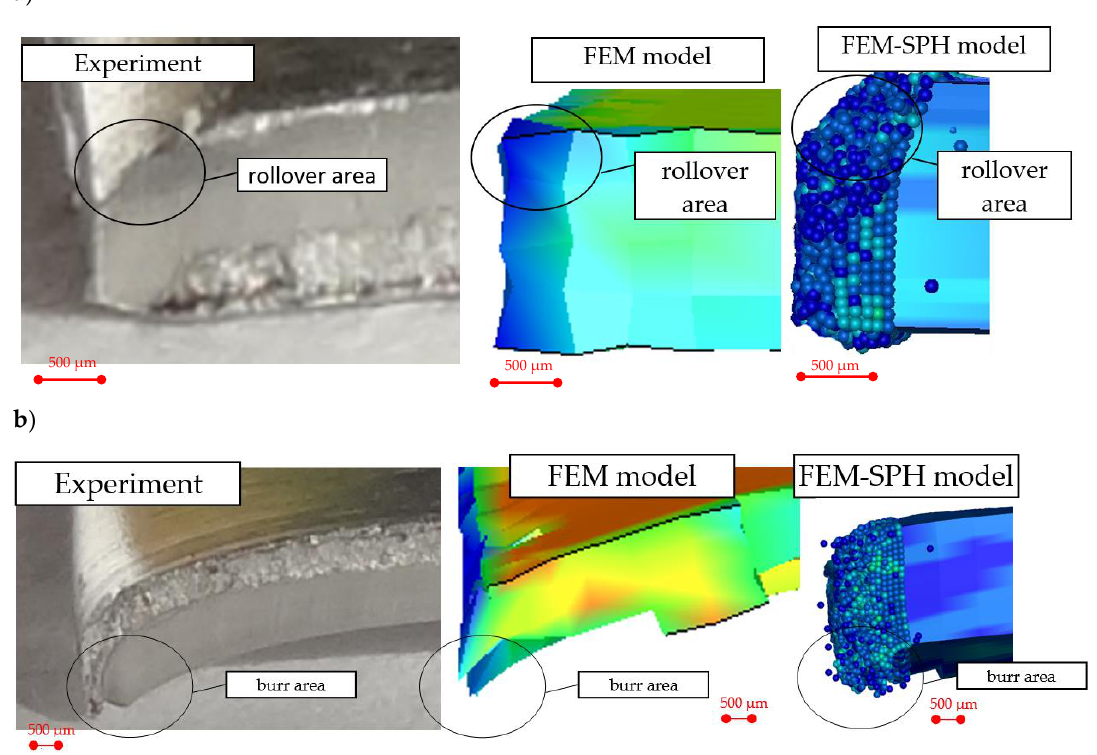
Figure 11. Characteristic features of the sheared edges obtained experimentally and numerically: ( a ) h c = 0.06 mm, ( b ) h c = 0.09 mm.